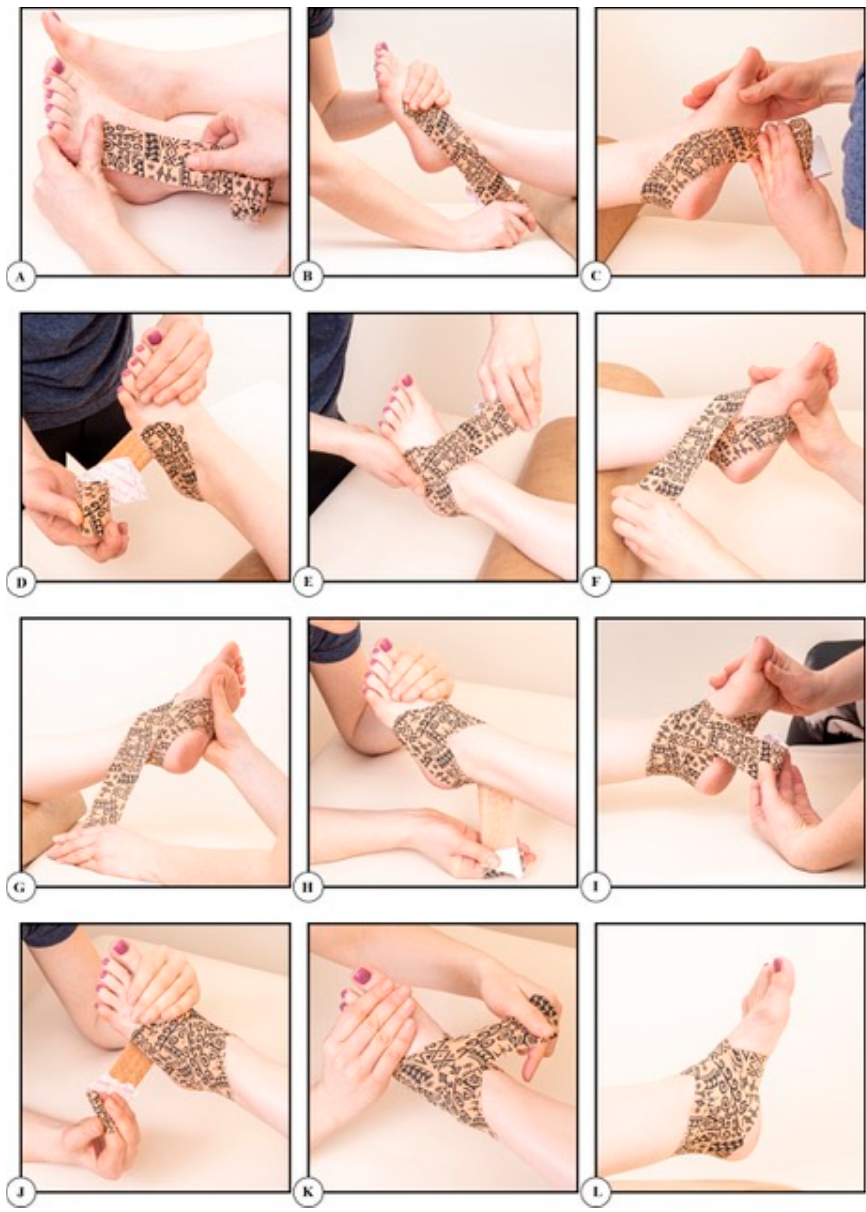
Figure 2. Application of dynamic tape.